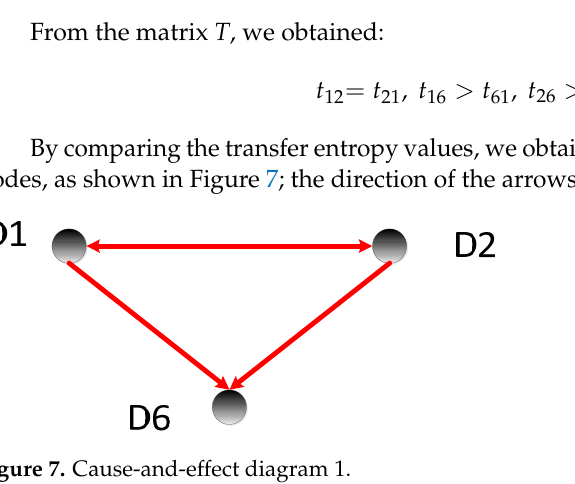
Figure 7. Cause-and-effect diagram 1.